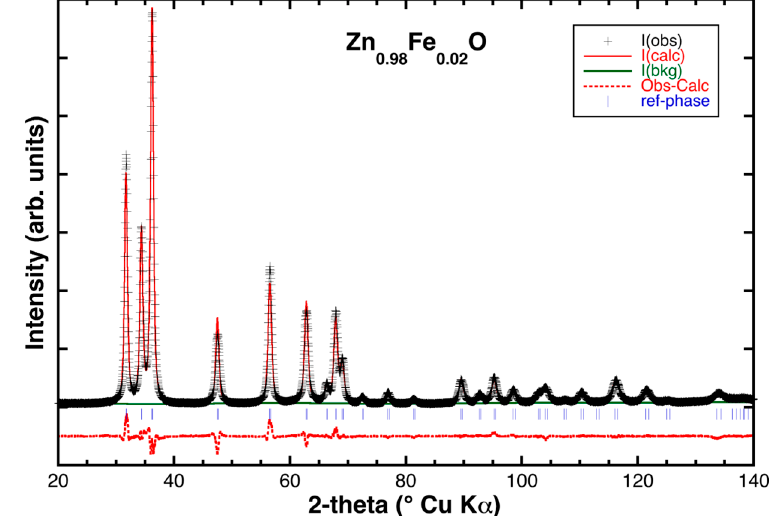
Figure 2. Typical Rietveld refinement of a Fe-doped sample (Zn 0.98 Fe 0.02 O): Black crosses mark the experimental data; the solid red and green lines represent the theoretical pattern and background function, respectively, while the dotted red line is the residual. Vertical blue lines mark the angular positions of the ZnO reflections.